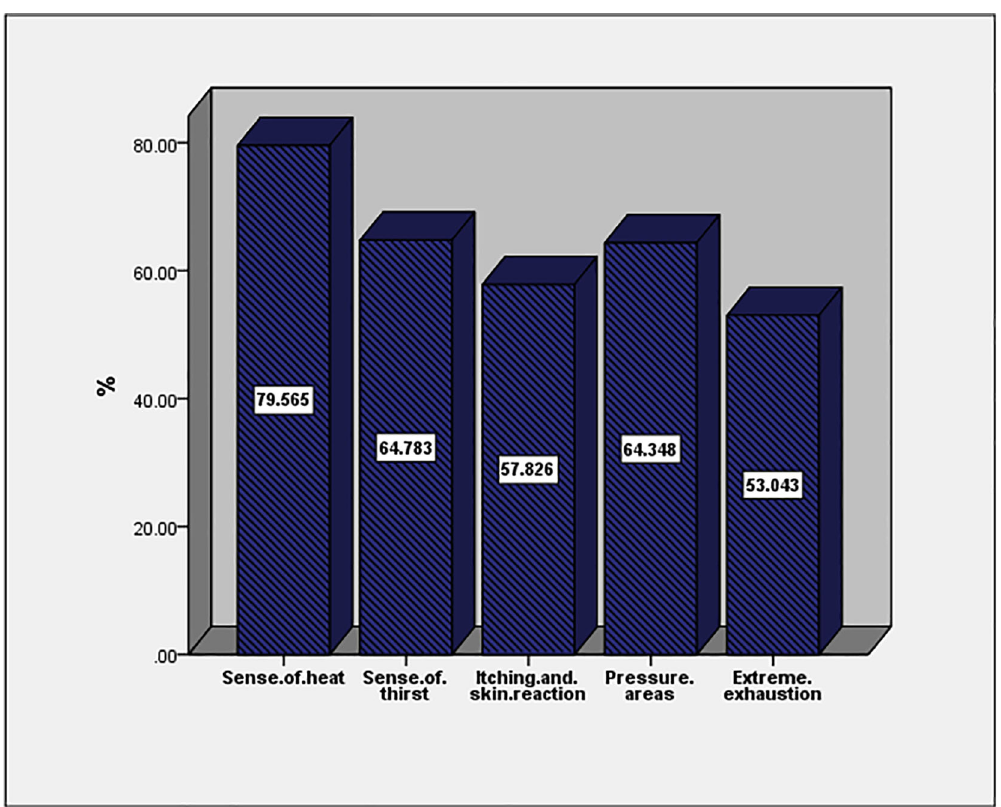
Figure 1. Adverse effects of full PPE use among study